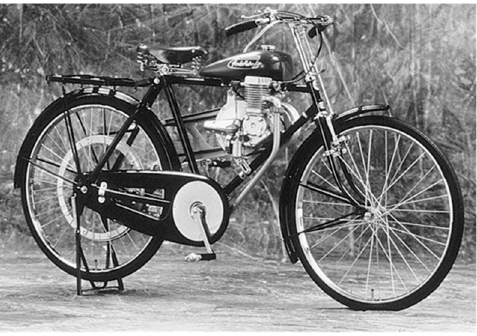
Figure 13. Soichiro Honda motorcycle (1947 Honda A-type—adapted from world.honda.com).